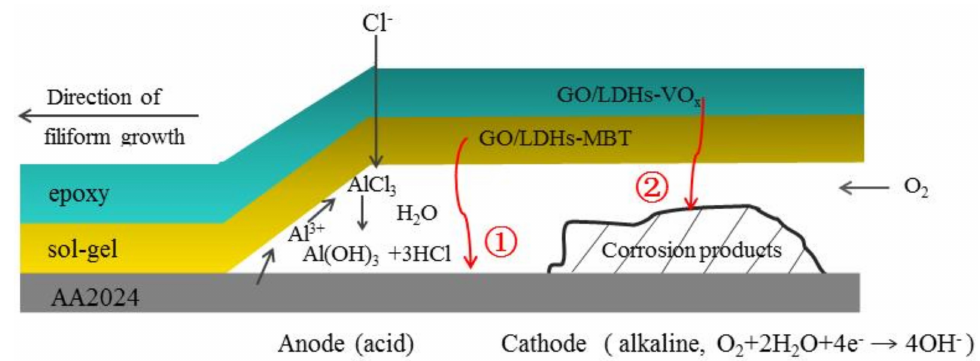
Figure 10. Schematic diagram of protective mechanism of the M + V coating: MBT anions inhibited